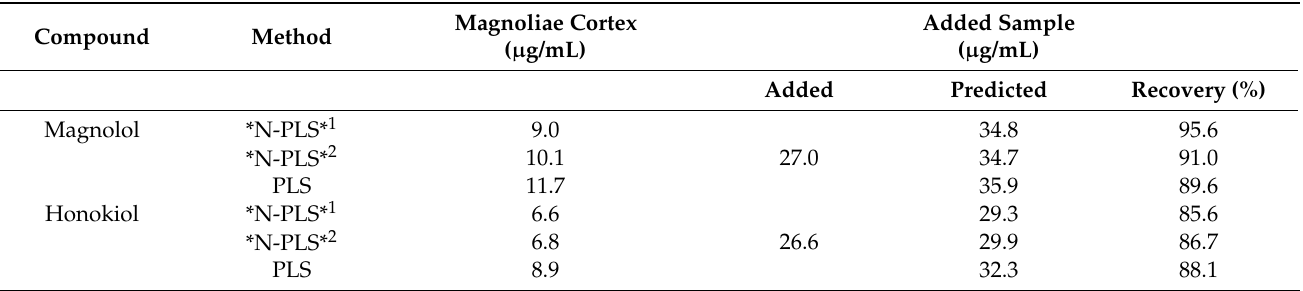
Table 3. Determination results of magnolol and honokiol in Magnoliae Cortex sample using different